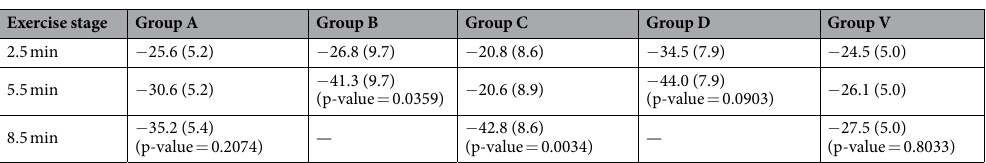
Table 2. Effect of group and exercise stage on mean † (standard error) reduced RVM scores. † Least square means are reported. Significant reduction in relative vector magnitude (RVM) scores at 5.5 minutes of exercise in groups B and D and at 8.5 minutes in Group C indicates induction of ischaemia at different levels of physical work hence severity of compromised myocardial perfusion.